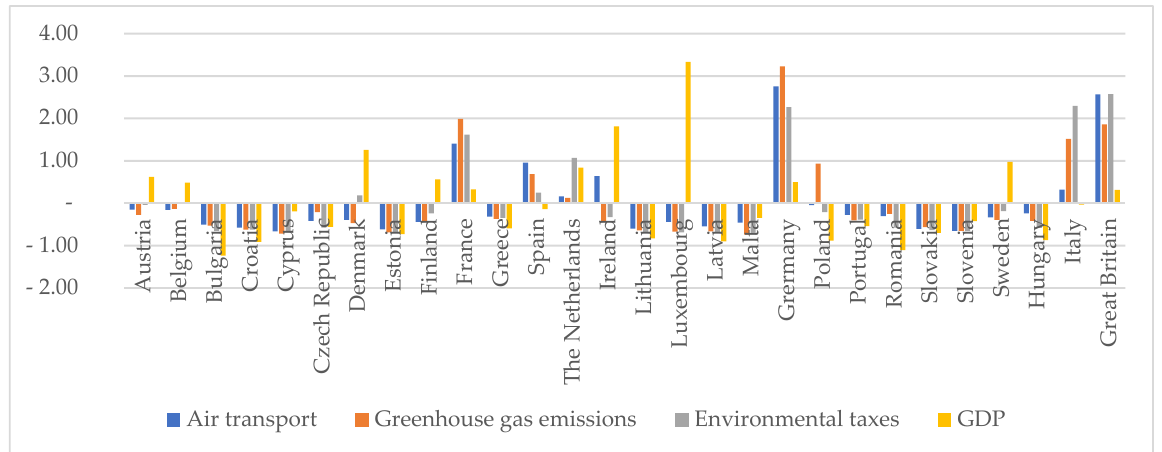
Figure A10. Distribution of European Union countries determined using Perkal index in 2018. Source: Reproduced from